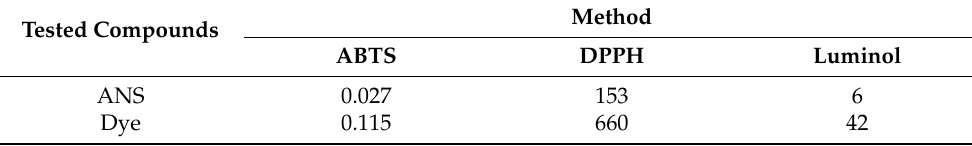
Table 5. Antioxidative potential of the ANS substrate and the dye obtained using different methods expressed as the effective concentration ( µ g/mL) of the tested compounds reducing 50% of radicals (IC 50